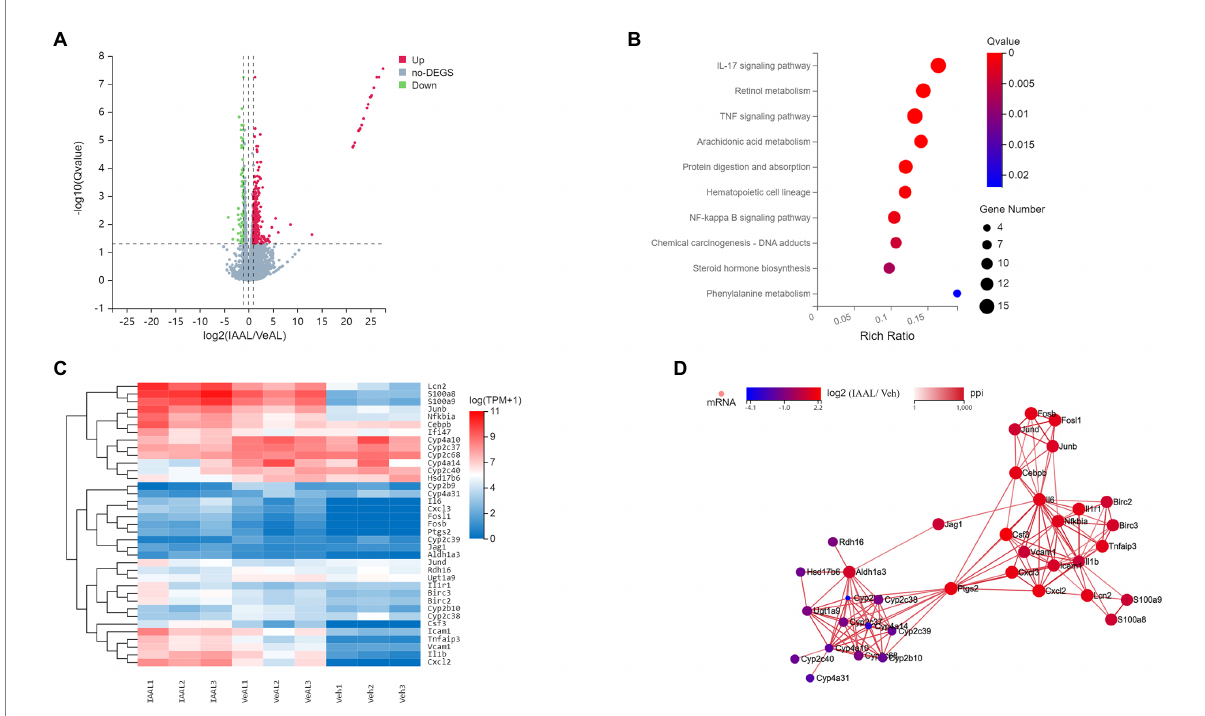
FIGURE 3 IAA alters liver transcriptome expression in D-GalN/LPS induced-ALF. (A) Volcano map for differential genes between VeAL and IAAL. (B) KEGG enrichment analyses of DEGs between VeAL and IAAL. (C) Heatmap of the DEGs from the four selected KEGG pathways. (D) Visualization of the four pathways’ network. Veh, Vehicle (saline control); VeAL, Vehicle + D-GalN/LPS; IAAL, IAA + D-GalN/LPS. n = 3 in each group.